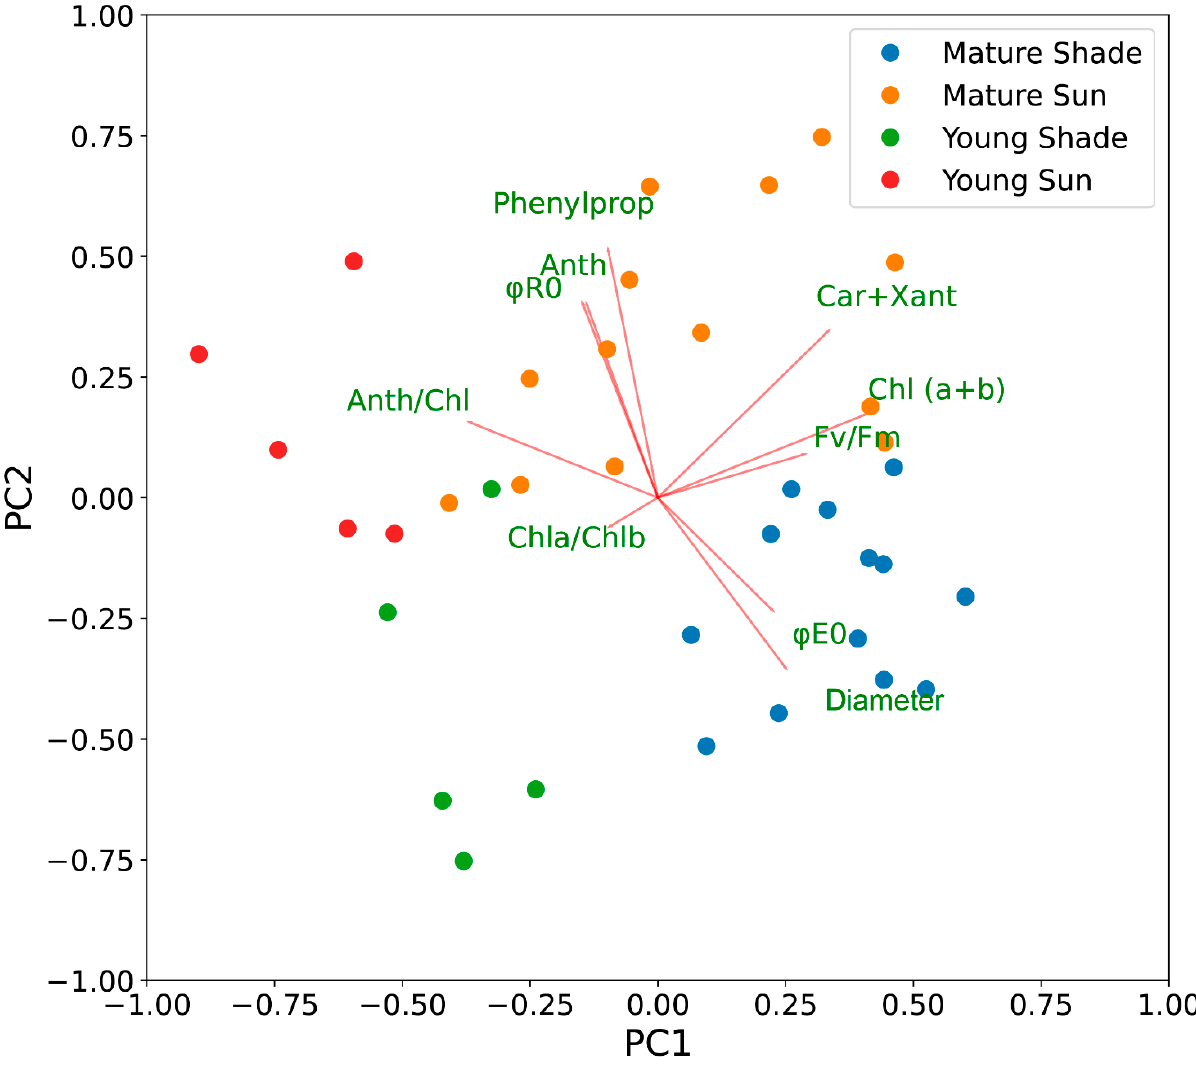
Figure 9. Principal component analysis (PCA) biplot of studied photosynthetic traits in leaves of H. morsus-ranae . The loadings of physiological traits are shown with red lines and labelled by green captions. The first principal component (PC1) is mainly associated with Chl ( a + b ) and F v /F m , whereas the second component (PC2) is associated with the content of phenylpropanoids, anthocyanins, and with ϕ R0. The locations of leaves in the ordination space are shown by circles filled with different colors, according to the experimental group, as also indicated in the legend: blue circles—mature leaves in the shade; orange—mature leaves in the sun; green—young leaves in the shade; red—young leaves in the sun. The groups are clearly separated on the ordination plot, indicating that they are different by multivariable traits. The leaf groups are separated along with PC1 by their development stage (young and mature ones), and along with PC2 by their lighting conditions (sun and shade ones), which indicates that these factors have different and independent effect on